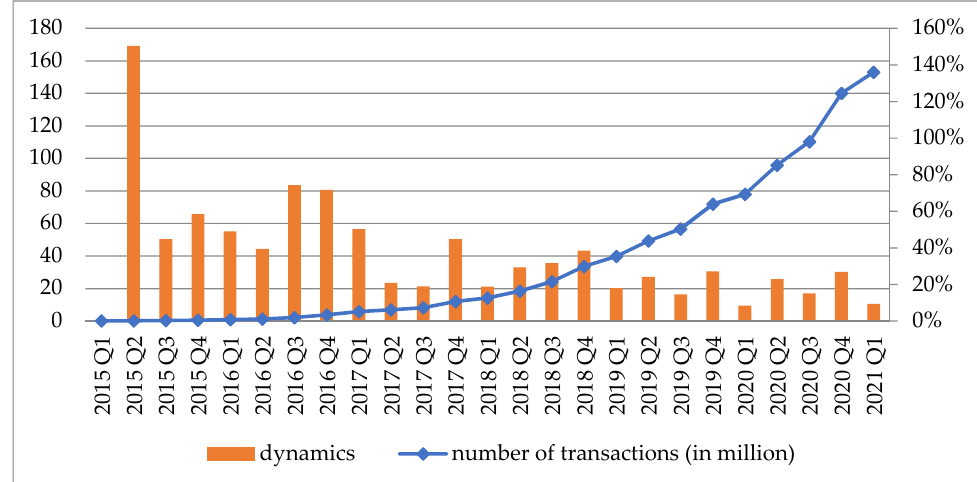
Figure 3. Number of transactions executed via BLIK and its dynamics. Source: own elaboration